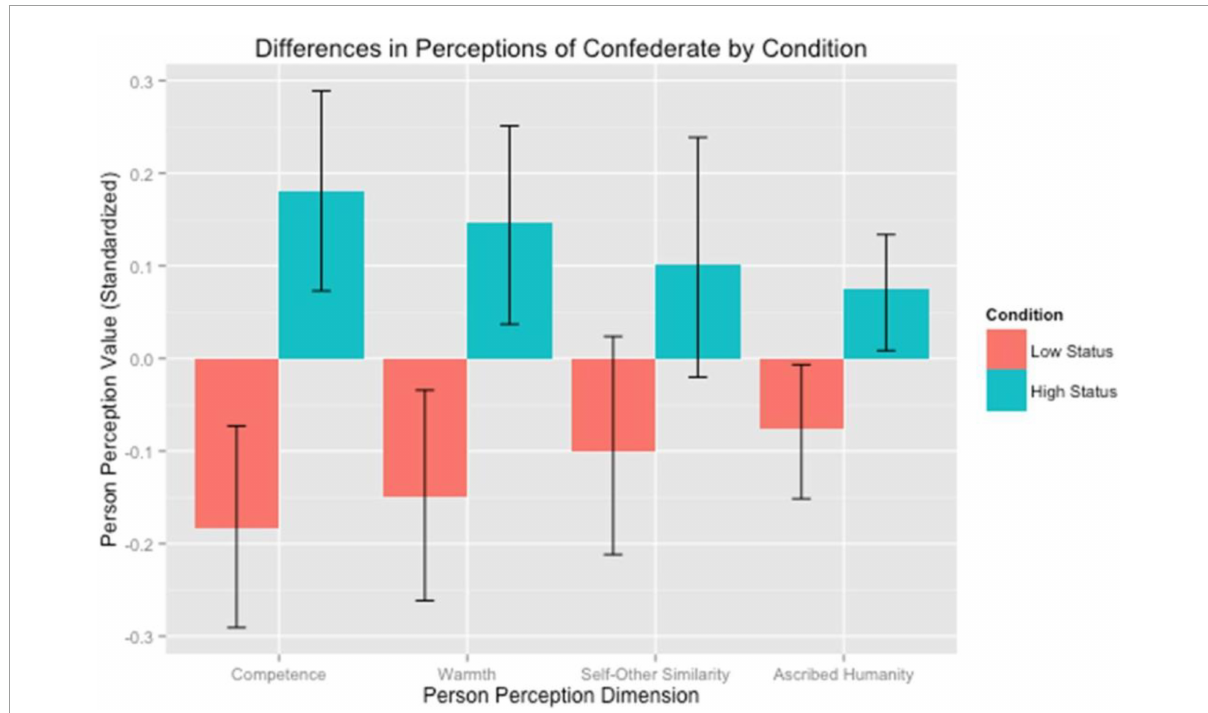
FIGURE2 Standardized mean perceptions of higher and lower status targets on dimensions of competence, warmth, self-other similarity, and ascribed humanity. Error bars represent bias-corrected and accelerated (BCa) bootstrapped 95% confidence intervals with 5,000 replications. Bennett Callaghan served as stimuli for the study